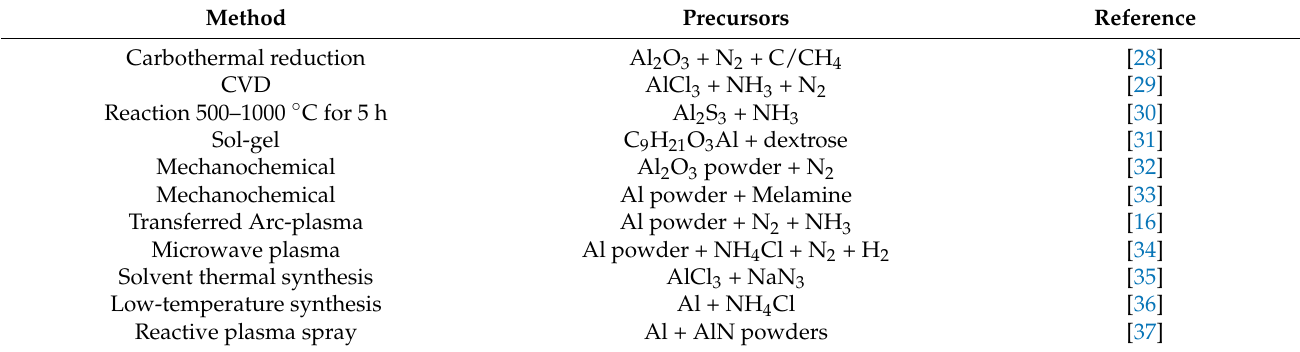
Table 3. Summary of different methods used for producing AlN